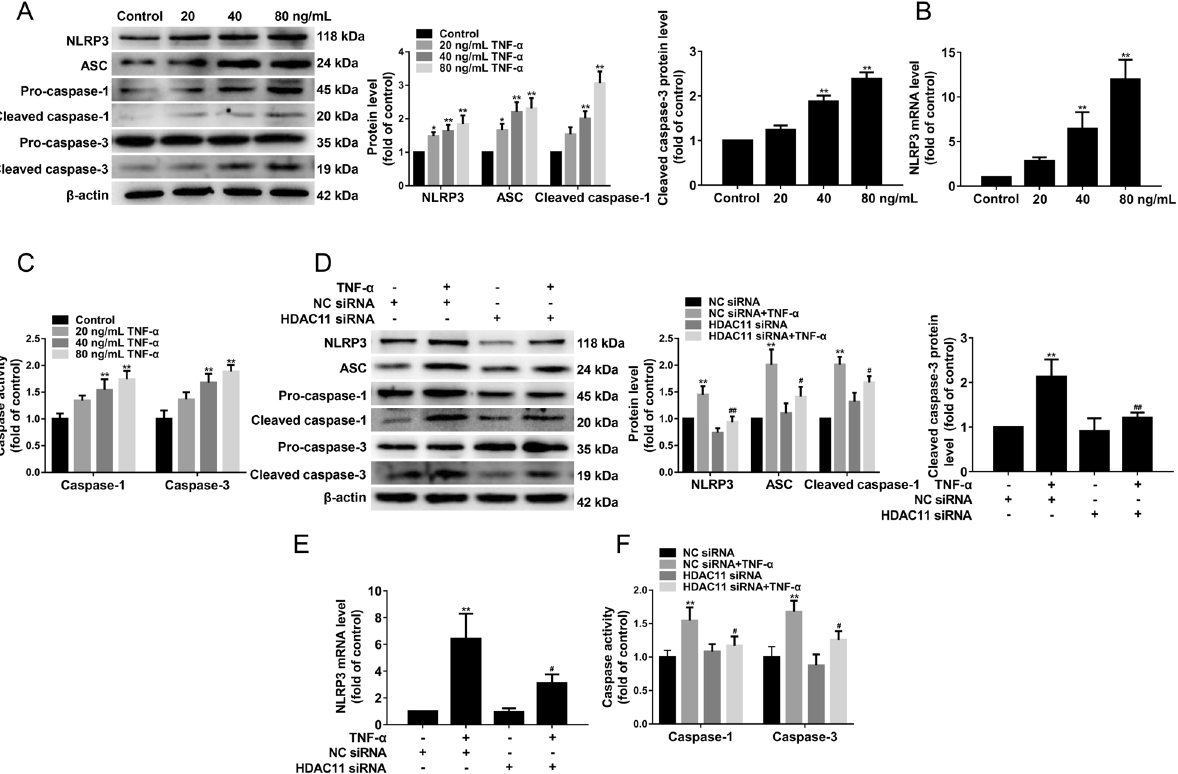
Fig. 5 HDAC11 knockdown suppresses both NLRP3/caspase-1/GSDMD and caspase-3/GSDME pathways in TNF- α -induced HUVECs. HUVECs were treated with TNF- α (20, 40, or 80 ng/mL) for 12 h. A The expressions of NLRP3, ASC, pro-caspase-1, cleaved caspase-1, pro- caspase-3, and cleaved caspase-3 were determined by Western blotting. B NLRP3 mRNA expression was assayed by quantitative real-time PCR. C Caspase-1 and caspase-3 activity were determined using the Caspase-1 activity assay kit and the Caspase-3 activity assay kit. * P < 0.05, ** P < 0.01 vs. control group. D HUVECs were stimulated with 40 ng/mL TNF- α for 12 h after their transfection with HDAC11 siRNA or NC siRNA for 48 h. The expressions of NLRP3, ASC, pro-caspase-1, cleaved caspase-1, pro-caspase-3, and cleaved caspase-3 were determined by Western blotting. E NLRP3 mRNA expression was assayed by quantitative real-time PCR. F Caspase-1 and caspase - 3 activity were determined using the Caspase-1 activity assay kit and the Caspase-3 activity assay kit. ** P < 0.01 vs. NC siRNA group; # P < 0.05, ## P < 0.01 vs. NC siRNA + TNF- α group. Results are expressed as mean ± SD ( n =